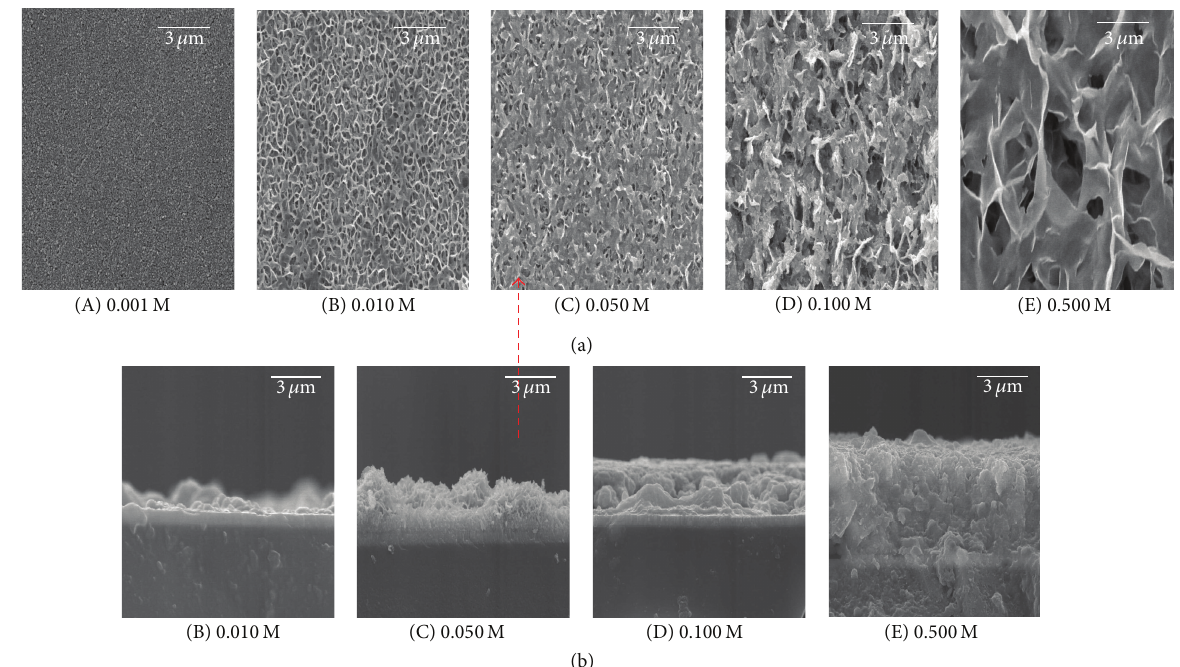
Figure 2: High-magnification SEM images (top view (a) and side view (b)) of the In 2 S 3 crystals grown on TiO 2 seed blocking layer.